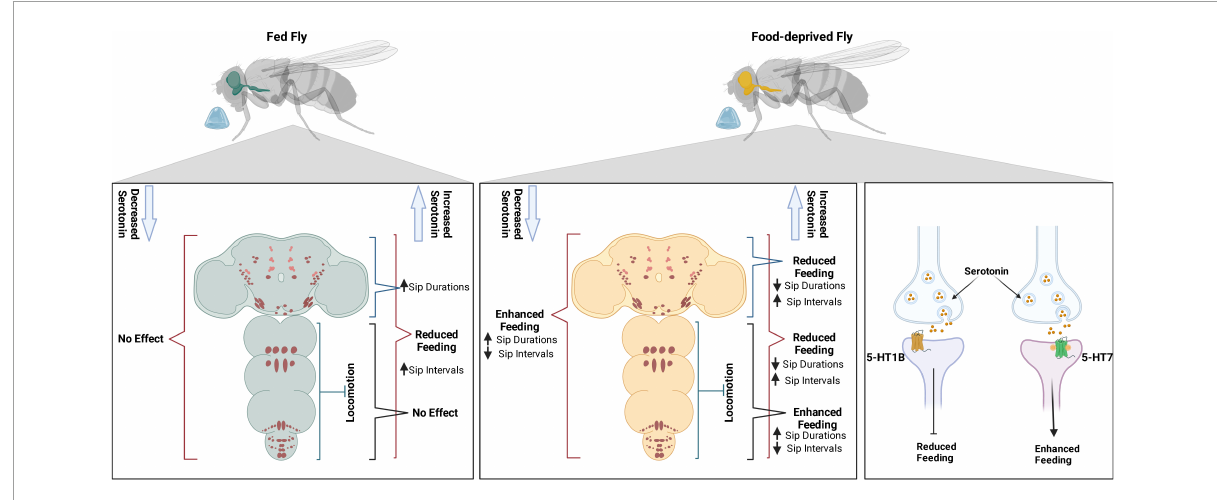
FIGURE6 Serotonin modulates feeding in a state-dependant manner using 5-HT1B and 5-HT7